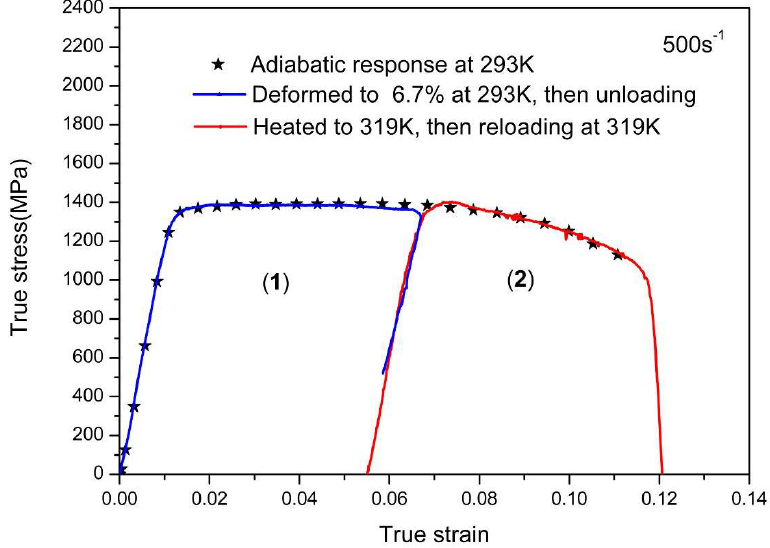
Figure 6. Results under the variable temperature loading.